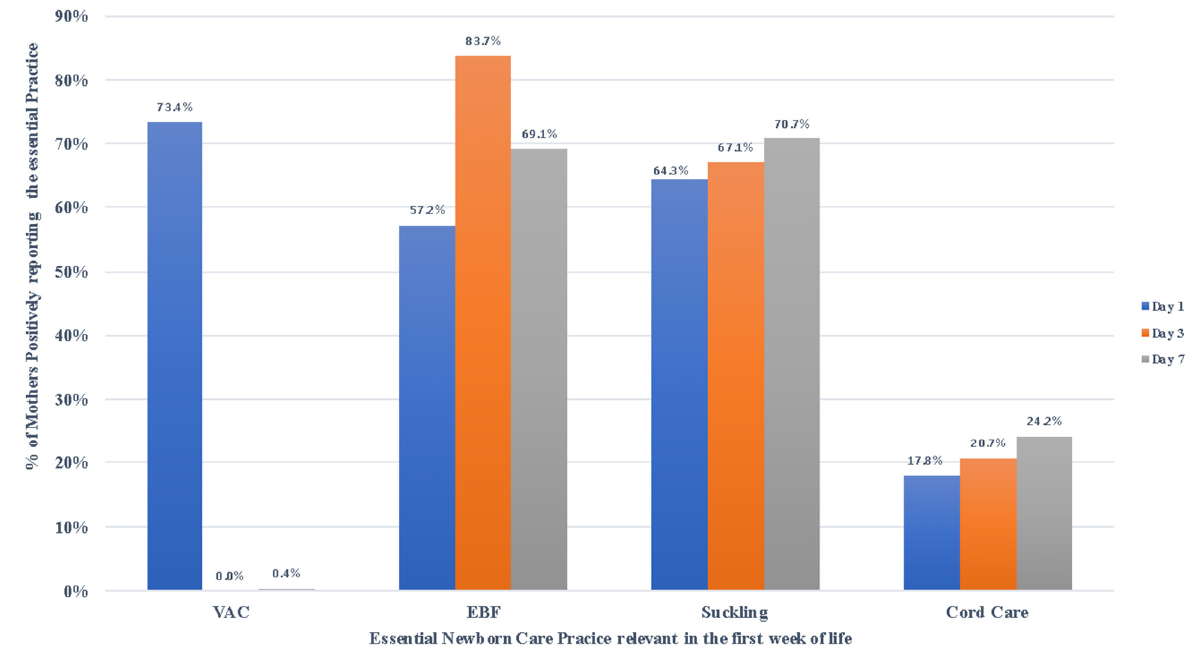
Figure 3. Essential newborn care during the first week. VAC = Newborns reported being vaccinated immediately after childbirth; EBF = Support to exclusively breastfeed; Suckling = Support to appropriate positioning and attachment of the newborn on the breast during feeding; Cord care = Support to practice appropriate cord care.